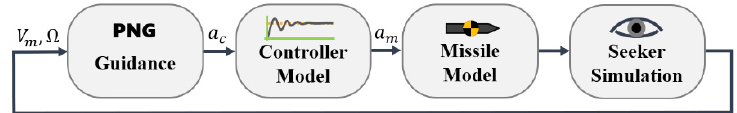
Figure 5. Missile simulation schematic diagram with proportional navigation guidance.